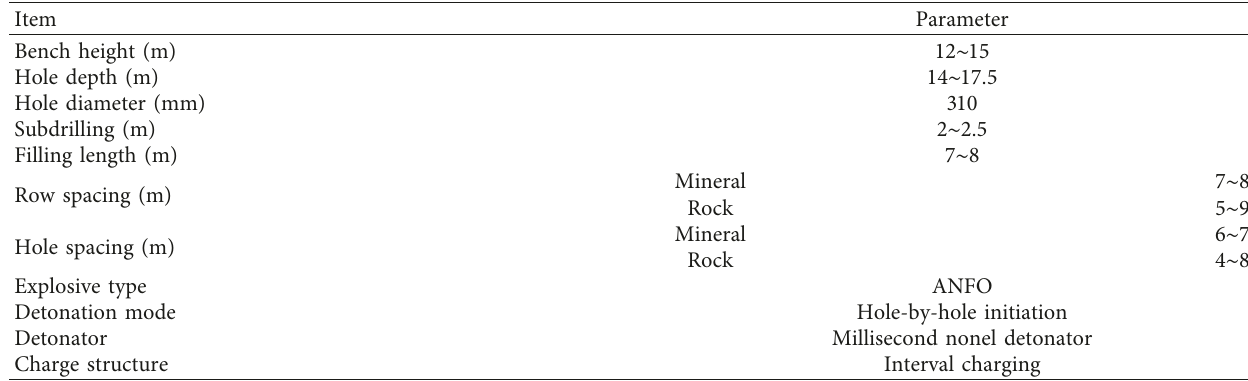
Figure 1: Field monitoring of blasting vibration velocity. Table 1: Blasting design parameters.